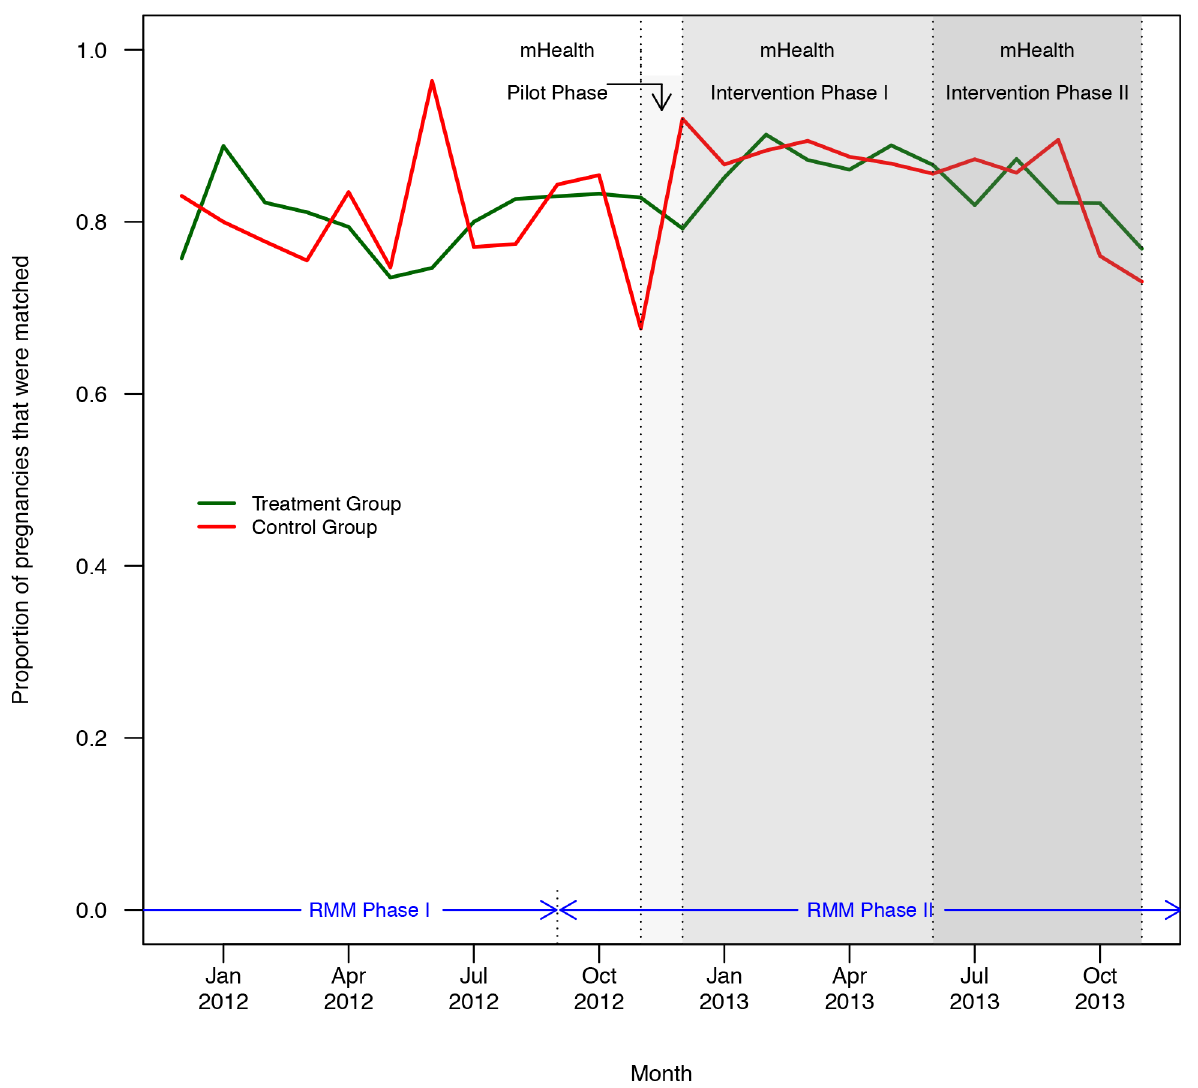
Fig 4. Proportion of matched pregnancies by group. Proportion of matched pregnancies by group during SMS baseline and intervention periods from December 2011 through November